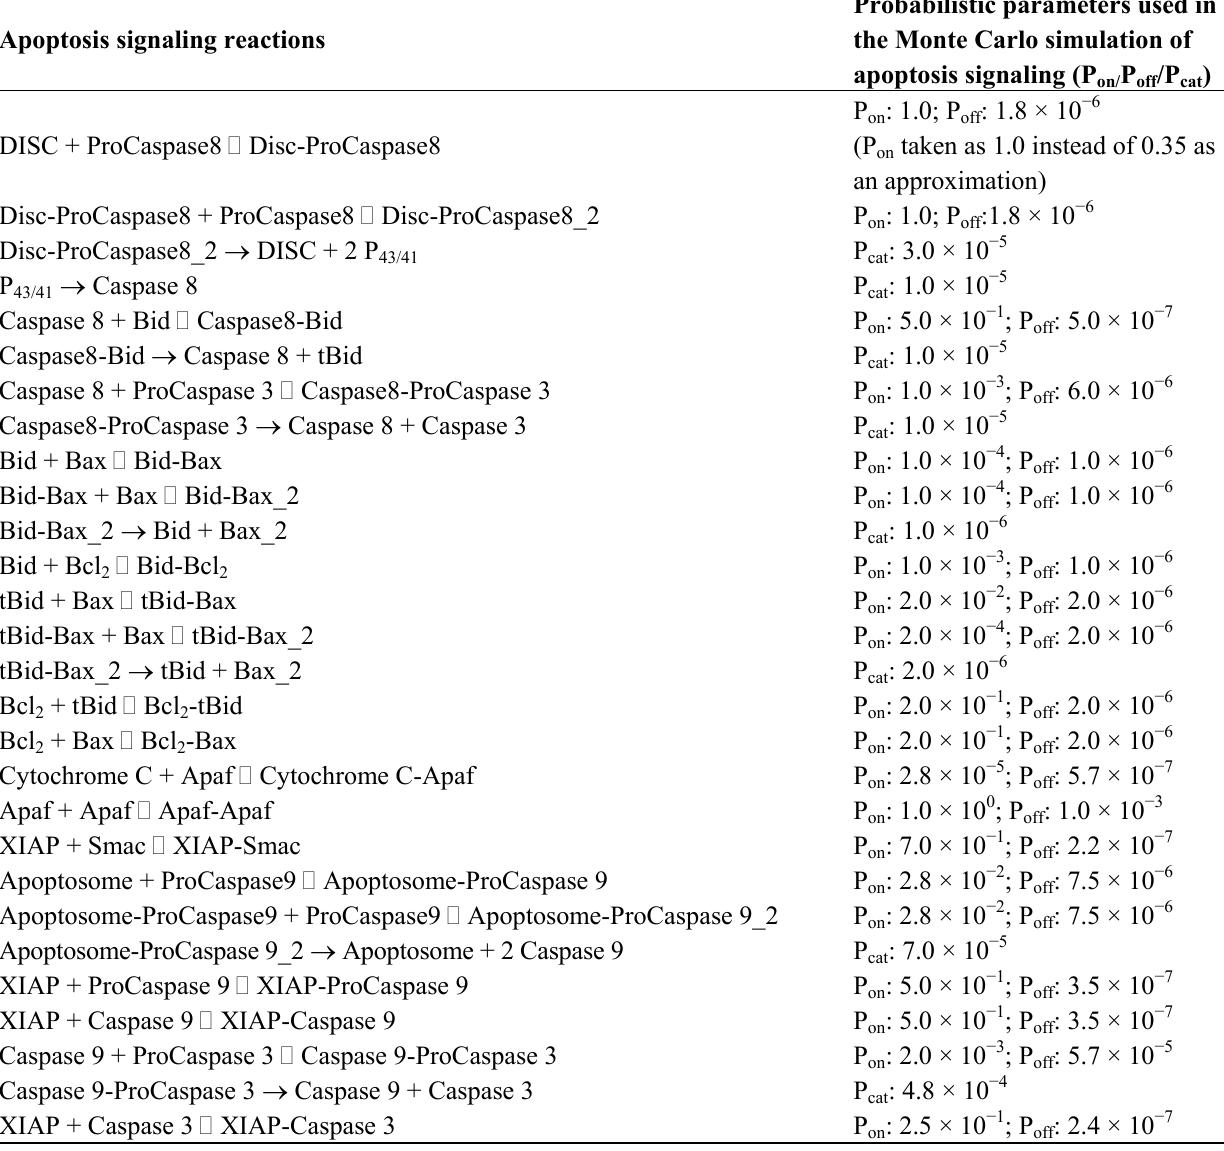
Table A3. Probabilistic simulation parameters.